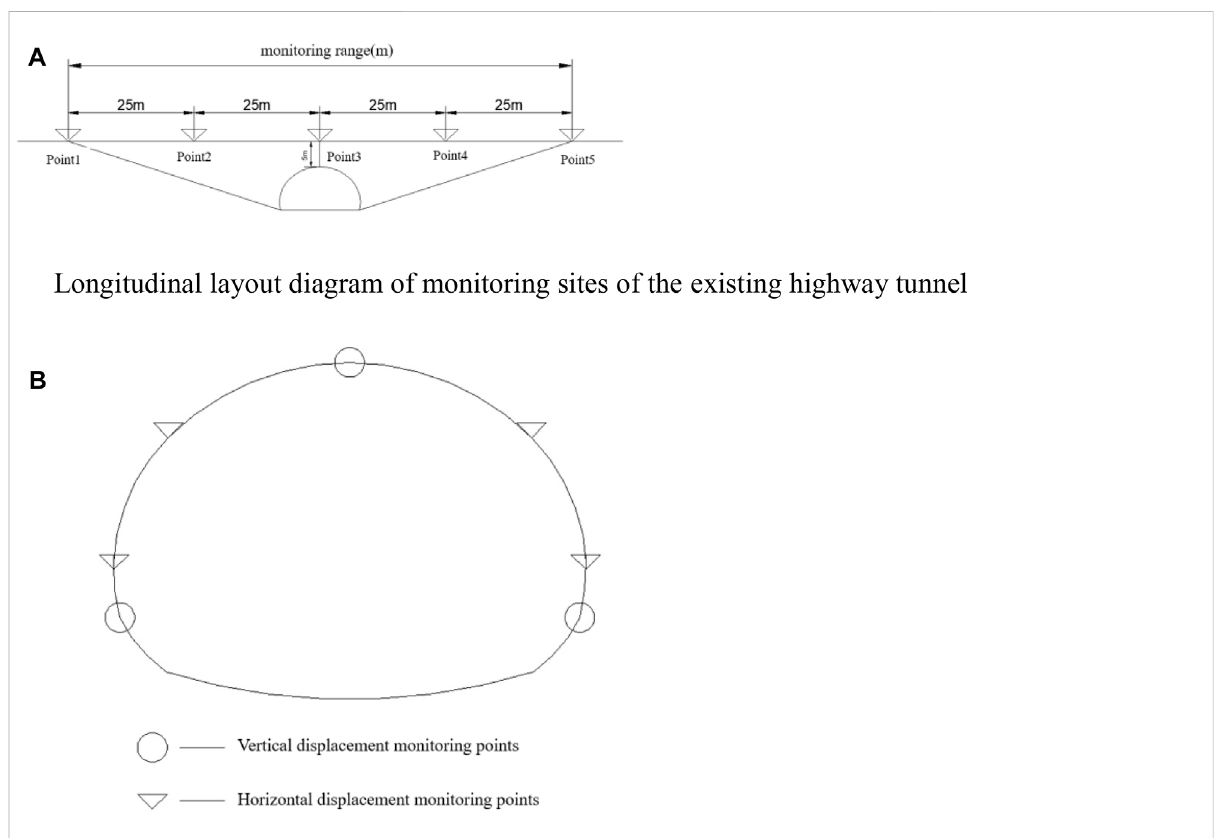
FIGURE 4 Layout of tunnel monitoring points. (A) Longitudinal layout diagram of monitoring sites of the existing highway tunnel. (B) Longitudinal layout diagram of monitoring sites on the cross-section of the existing highway